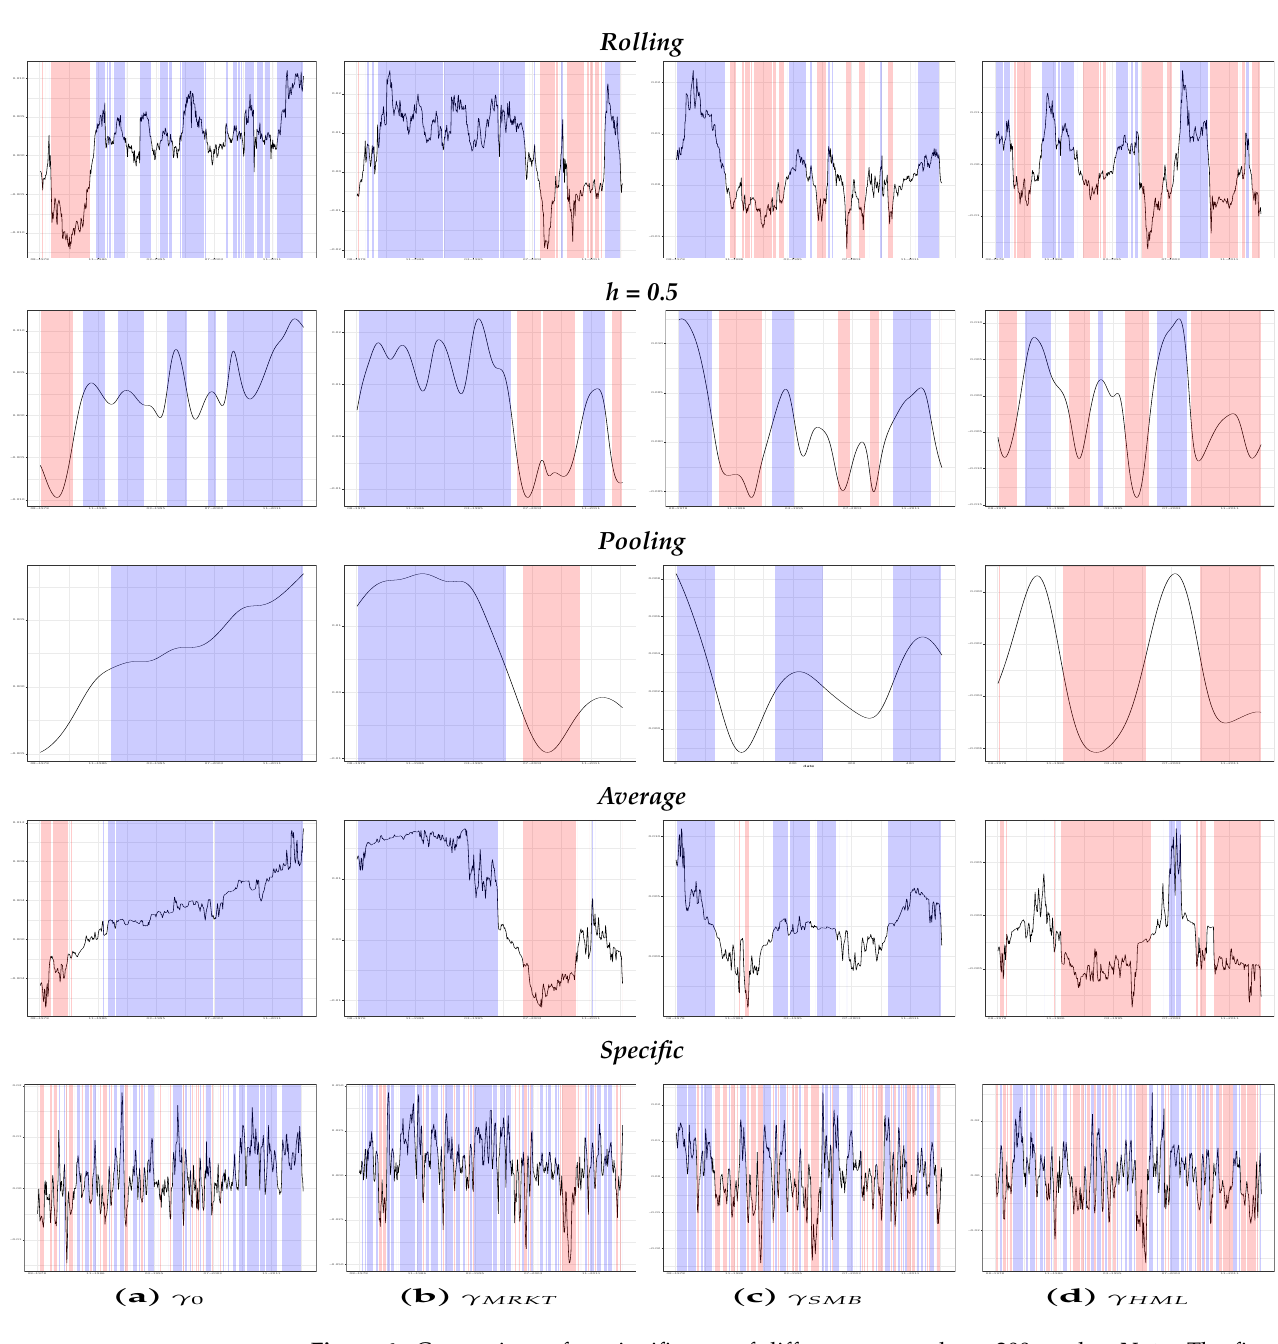
Figure 6. Comparison of γ s significance of different approaches—200 stocks. Note: The figure provides a significance analysis of the estimates of risk premium estimates. The blue areas are periods in which the estimates are statistically positive at a 5% level of significance, while the red ones identify periods in which the estimates are negative. The series were computed using different approaches: Rolling window ( FMcB approach), h = 0.5; Polling a single value of h coming from the poll average across assets and time (Equation (7)); Average , a unique time-varying bandwidth coming from the average of h across assets (Equation (8)); Specific , multiple time-varying bandwidths, one for each asset and time. The choice of the optimal bandwidth parameter h opt has been made using the kernel t approach as discussed in Equation